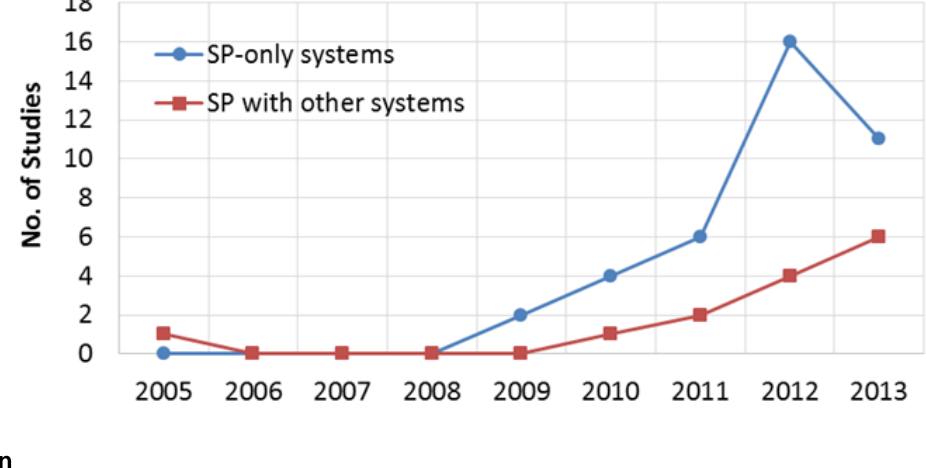
Figure 5. Estimation of the number of SP based fall detection and prevention